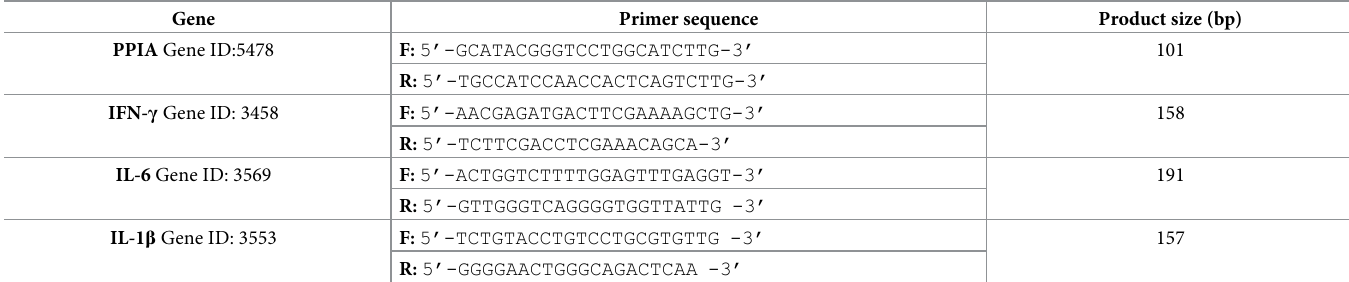
Table 1. List of primer sequences used for qPCR analysis in this